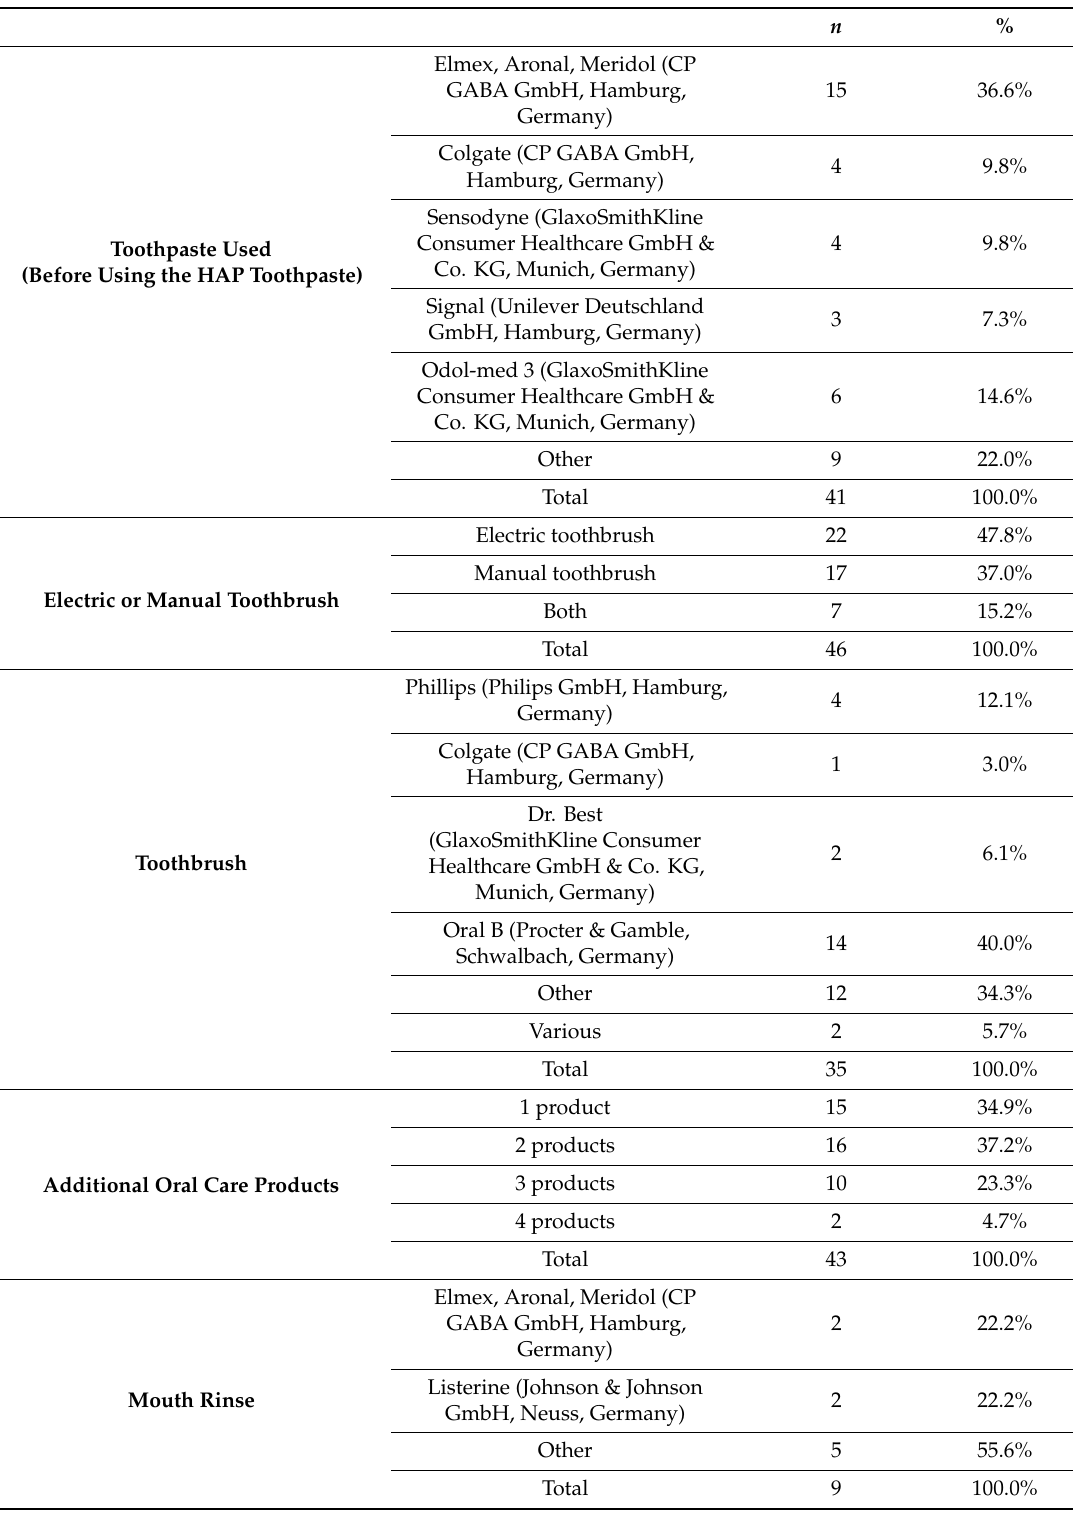
Table 2. Overview of toothpastes, toothbrushes, and other dental care products used by the patients before baseline.